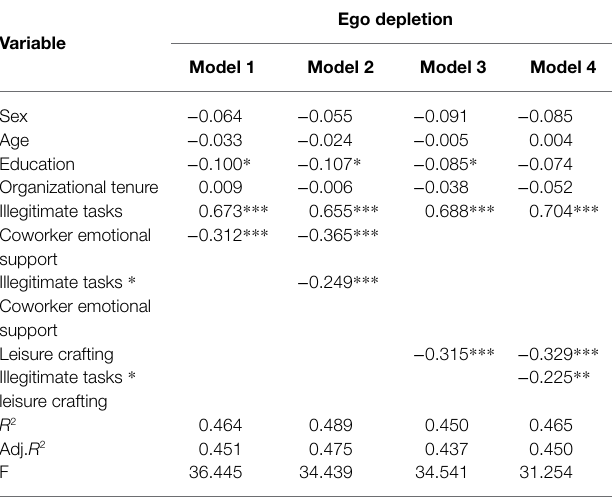
TABLE 5 | Results for moderating effect